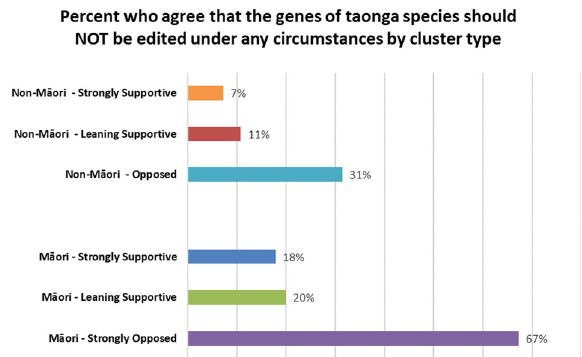
Fig. 9 Percent who are opposed to editing taonga species under any circumstances by clusters. Only one cluster, M ā ori Strongly Opposed, have a large percentage (67%) of cluster members who agree that the taonga species should never be edited. The other fi ve cluster types have a minority of members who support the stance of never allowing GEd to be used on native species. Non-M ā ori Strongly Supportive are shown in orange, non-M ā ori Leaning Supportive red, non-M ā ori Opposed light blue,M ā ori Strongly Supportive dark blue, M ā ori Leaning Supportive green, and M ā ori Strongly Opposed purple.